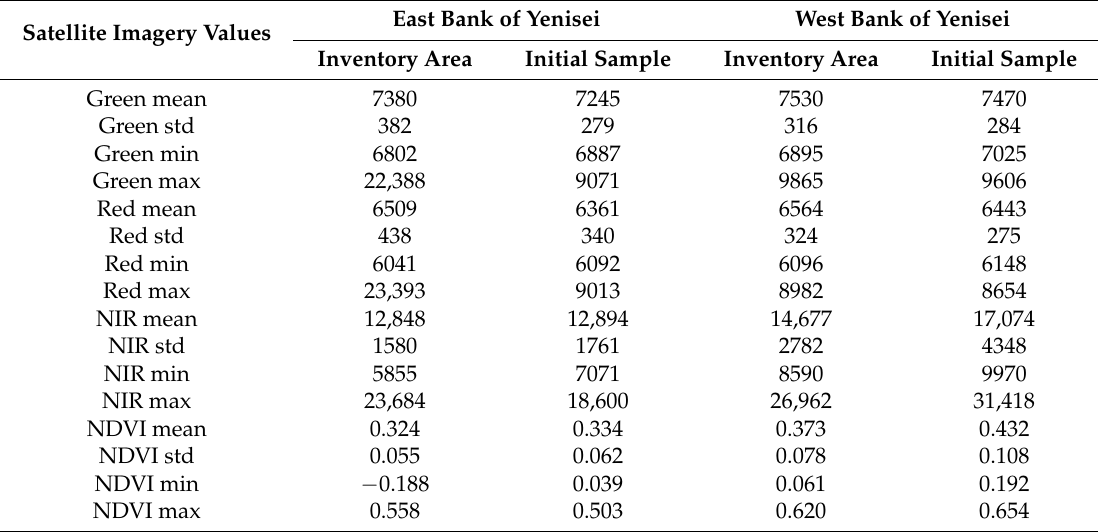
Table 1. Mean, standard deviation (std), and minimum (min) and maximum (max) of Landsat 8 Operational Land Imager (OLI) bands and normalized difference vegetation index (NDVI) values from random sample presenting whole AOI and from revised field sample locations (n = 792) for the east and the west bank of the